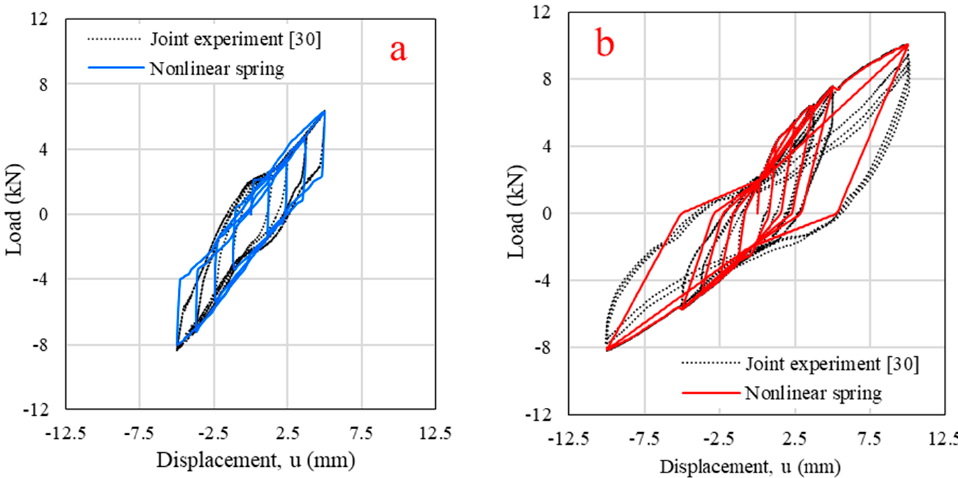
Figure 9. Nonlinear spring calibration with previous experiment for ( a ) Standard half-lapped corner joint (CJ-SHL); ( b ) Angle bracket first log-foundation connection (LF-AB).